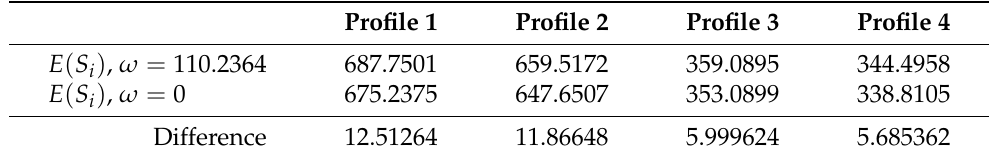
Table 4. Pure premium in collective model using parameters of Model